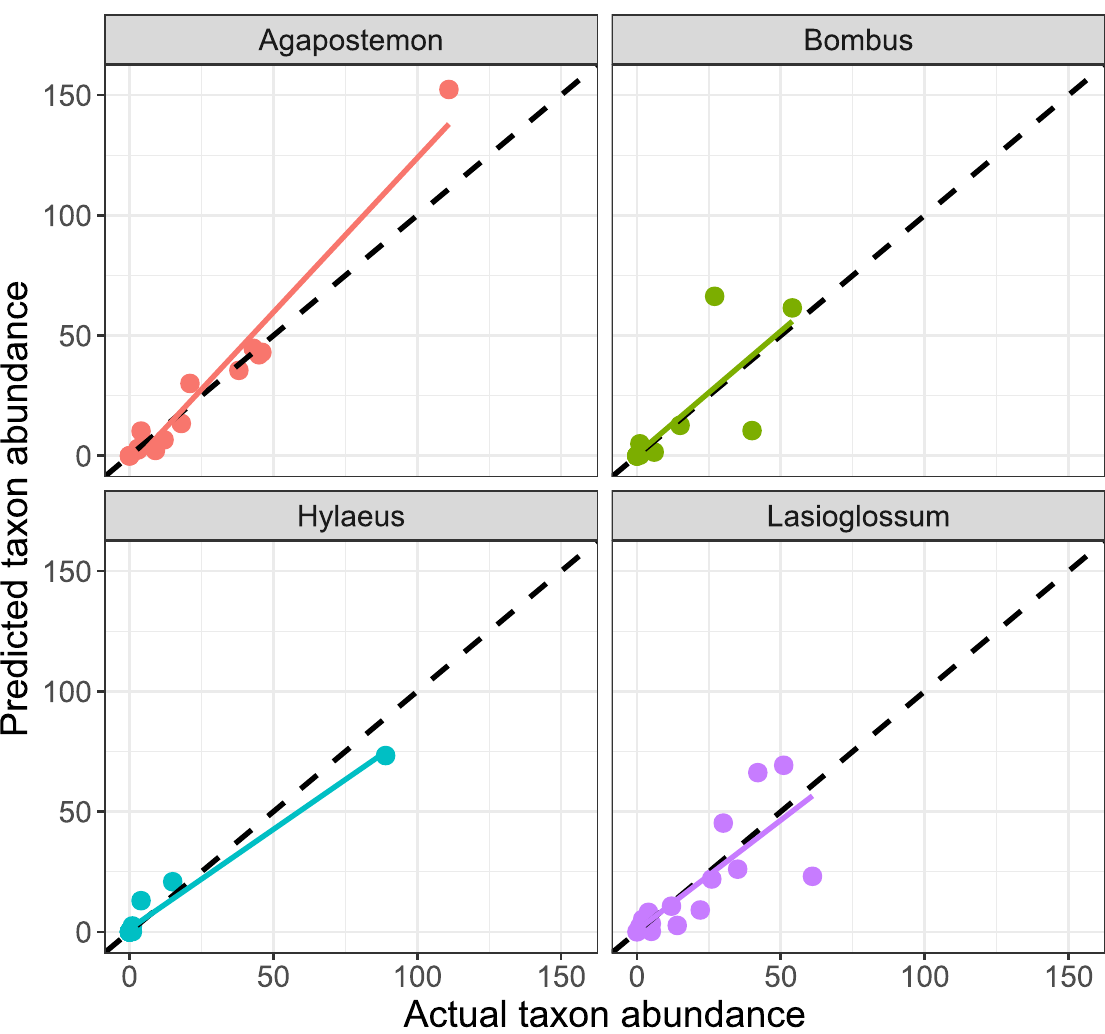
counts (horizontal axis). Each marker color represents a different taxon, the dashed black line represents the (ideal) 1:1 reference line; each colored line represents the best fit for that